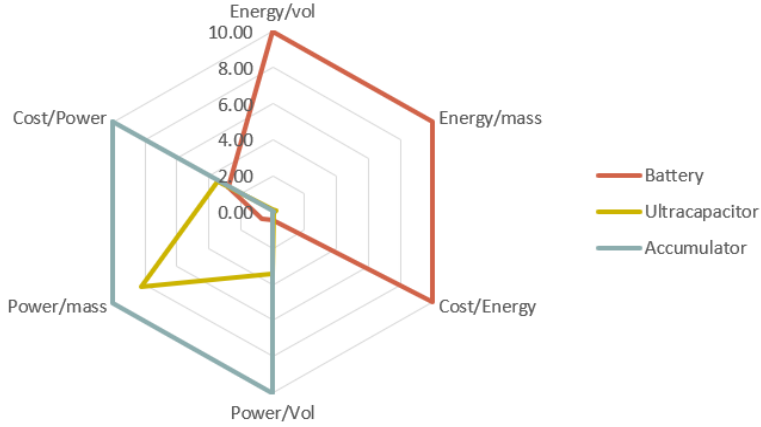
Figure 29. Radar plot comparing three energy storage systems.